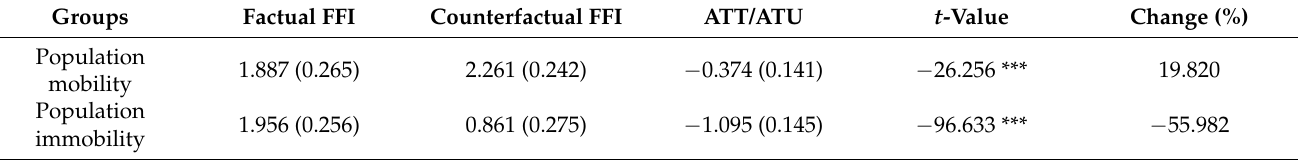
Table 5. The impacts of RPM on